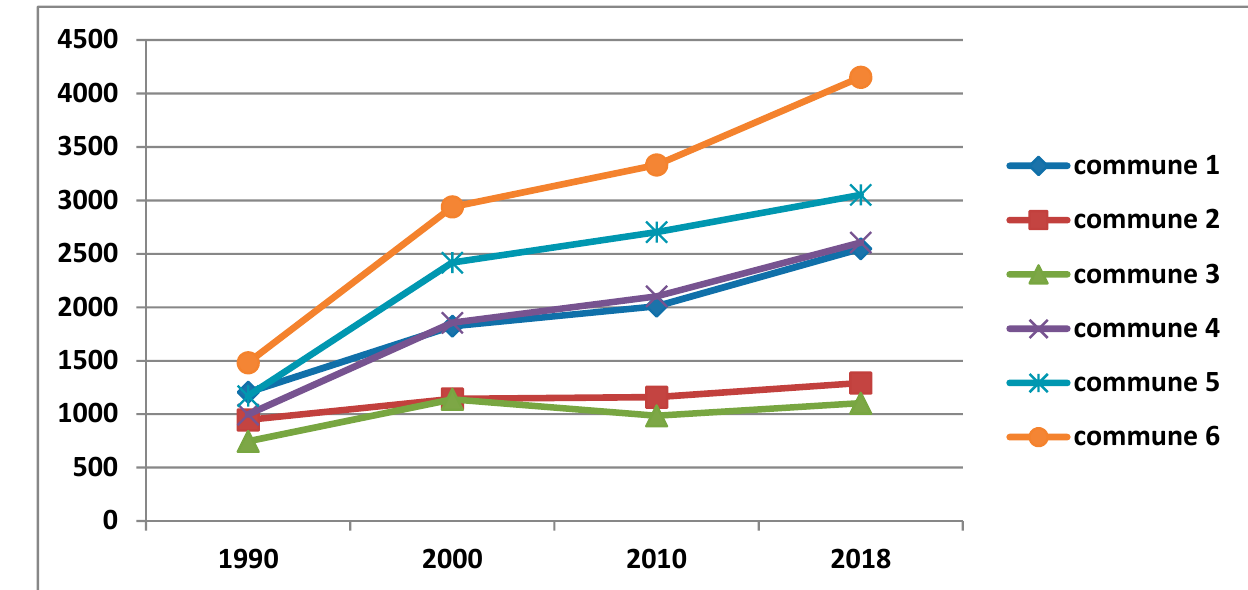
Figure 7. Curve trends of CA between communes in Bamako district. PLAND values increase for each commune over the study period; however, it is important to note that there is no agreement between trends of CA and PLAND by making comparisons between communes. Communes 3 and 2, which registered the lowest values of CA, have almost the highest value of PLAND over the study period, while commune 6 which scored the highest value of CA, had the lowest value of PLAND in the study period. This is not normal, but it can be explained by the effects of the difference of spatial domain, as mentioned before. Communes 3 and 2 have the smallest areas among the communes.